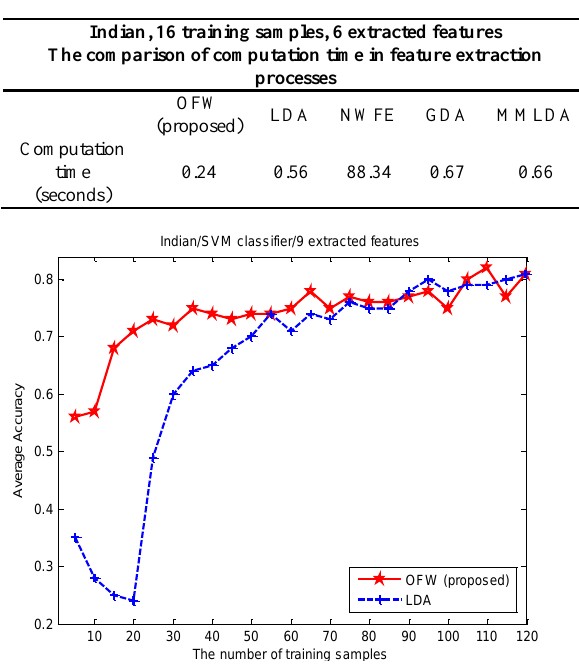
Table 6. Comparison of computation time of feature extraction process obtained by 16 training samples and 6 extracted features for Indian dataset.